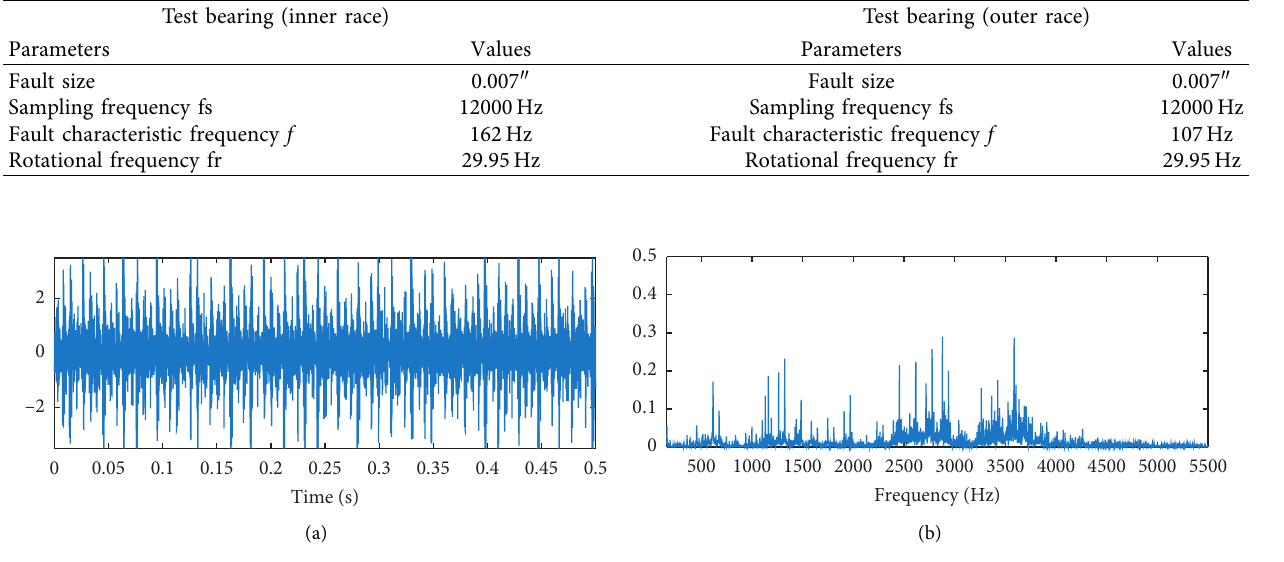
Figure 9: The original signal (a) time domain and (b) frequency domain.